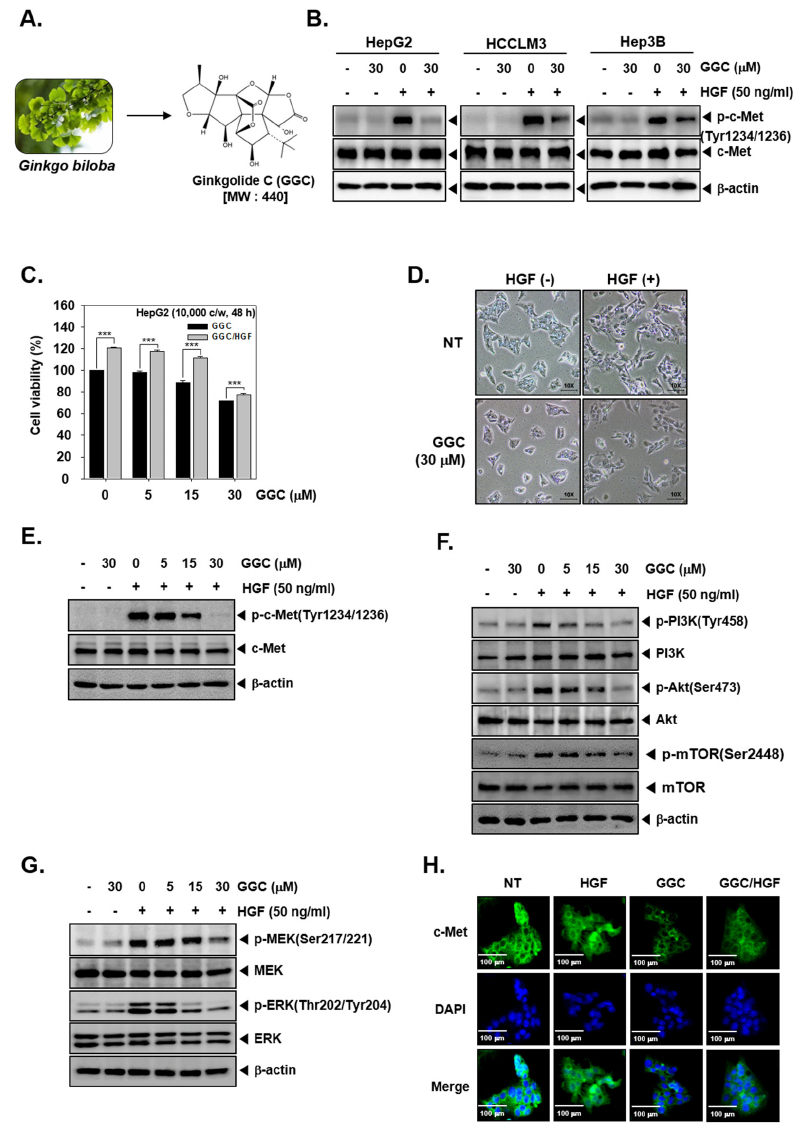
Figure 1. GGC suppresses HGF-induced Met phosphorylation. ( A ) Ginkgo biloba picture and chemical structure of Ginkgolide C (GGC). ( B ) HepG2, HCCLM3, and Hep3B cells (5 × 10 5 cells / well) were pre-treated with GGC 30 µ M for 2 h, then HGF (50 ng / mL) treated for 30 min and western blotting for p-cMet(Tyr1234 / 1236) and c-Met was done. ( C ) HepG2 cells (1 × 10 4 cells / well) were pre-treated with (0, 5, 15, 30 µ M) of GGC for 2 h, then HGF (50 ng / mL) treated for total 48 h and MTT assay was done. Data represent means ± SD. *** p < 0.001 compared to the control. ( D ) HepG2 cells (2 × 10 5 cells / well) were seeded on 6 well plate. GGC (30 µ M) was pre-treated for 2 h, then HGF (50 ng / mL) treated for total 24 h. Morphological changes were observed by Nikon ECLIPSE Ts2 (Nikon corporation, Japan). ( E – G ) HepG2 cells (5 × 10 5 cells / well) were pre-treated with various concentrations of GGC for 2 h, then HGF (50 ng / mL) treated for 30 min and western blotting was done. ( H ) HepG2 cells were pre-treated with GGC (30 µ M) for 2 h, then HGF (50 ng / mL) stimulated for 30 min and c-Met distribution was analyzed by immunocytochemistry (scale bar: 100 µ m). The results shown are representative data of three independent